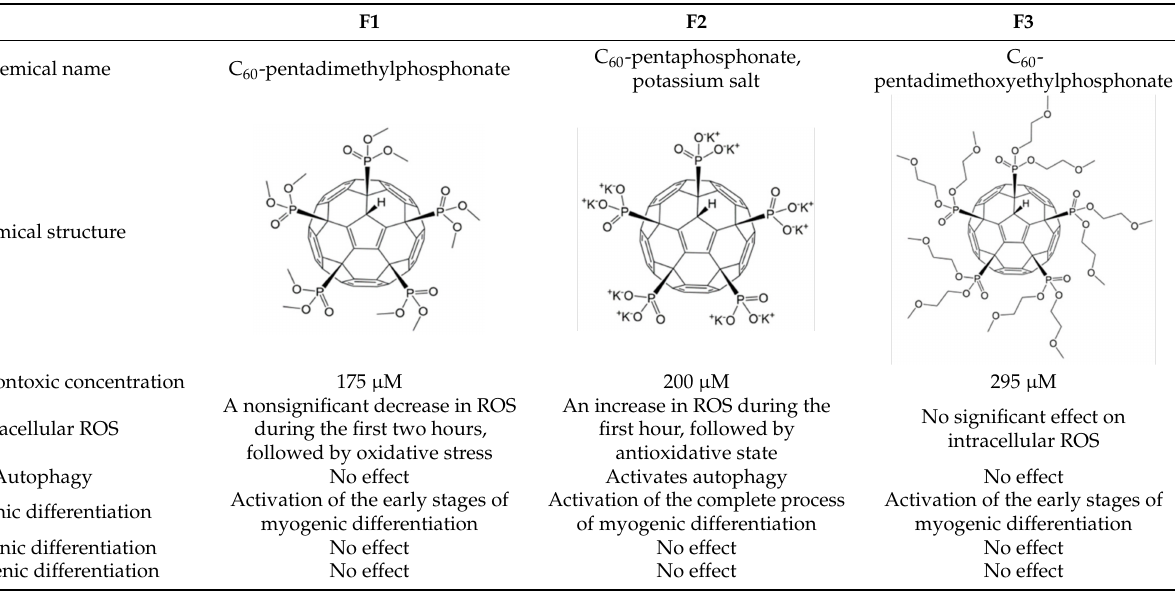
Table 1. Influence of the studied phosphonate fullerene derivatives on MSC differentiation lineage, intracellular ROS, and